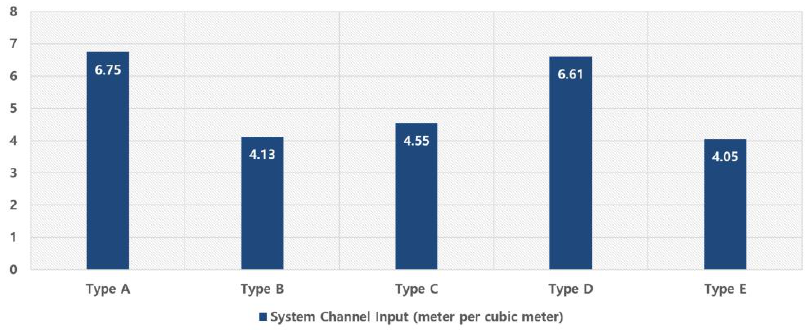
Figure 7. Material cost analysis (system channel input for manufacturing).